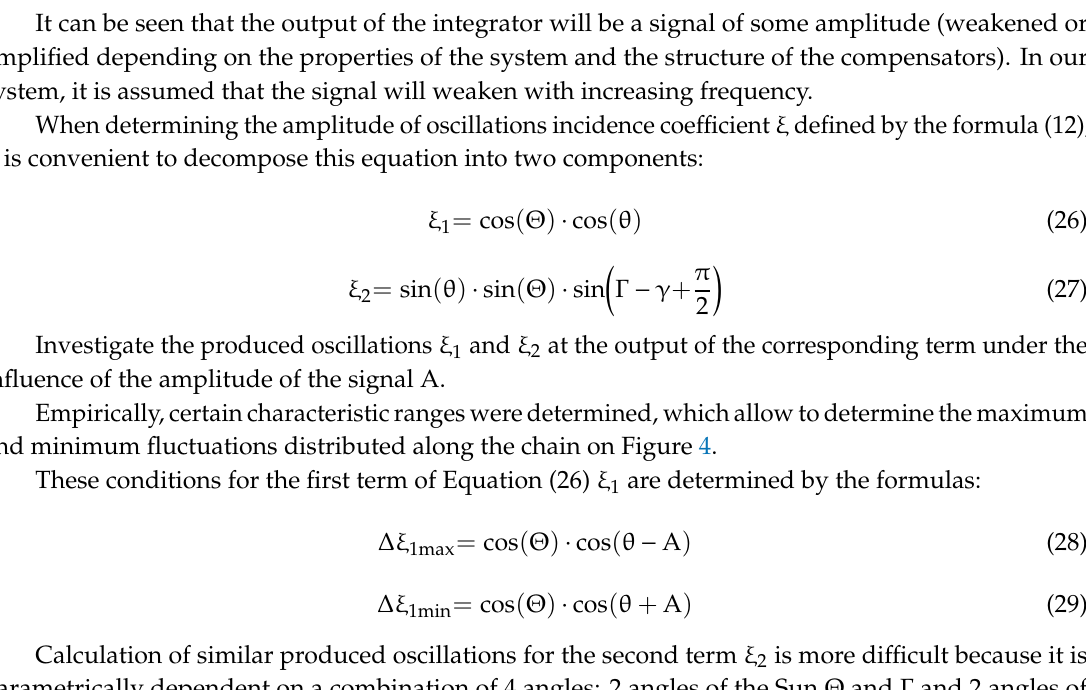
Table 1. The conditions by which the lower and upper boundaries of oscillations of the second term of Equation (16) are calculated.